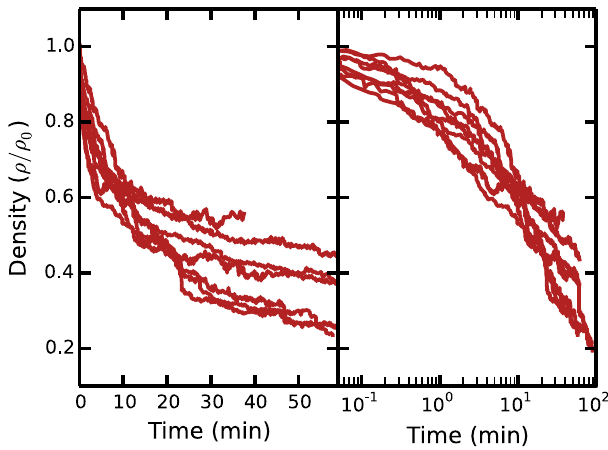
Fig. 4 Dislocation recovery kinetics for eight networks with initial densities in the range 4 – 12 x 10 14 m − 2 . The normalized density is shown following sudden heating to 500 C as a function of time on both linear (left) and logarithmic (right) scales.